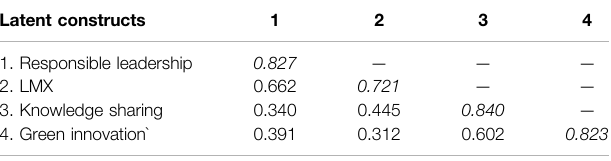
TABLE 2 | Discriminant validity test results. Latent constructs